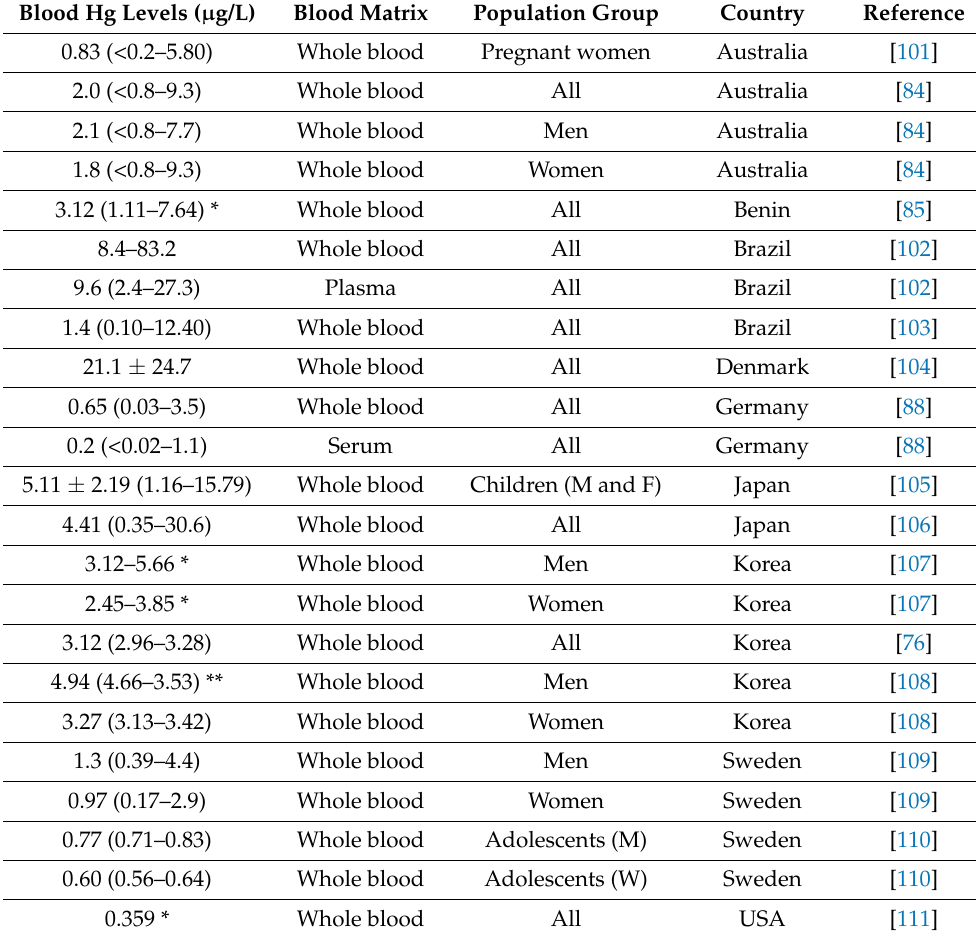
Table 6. Mercury levels in blood from selected